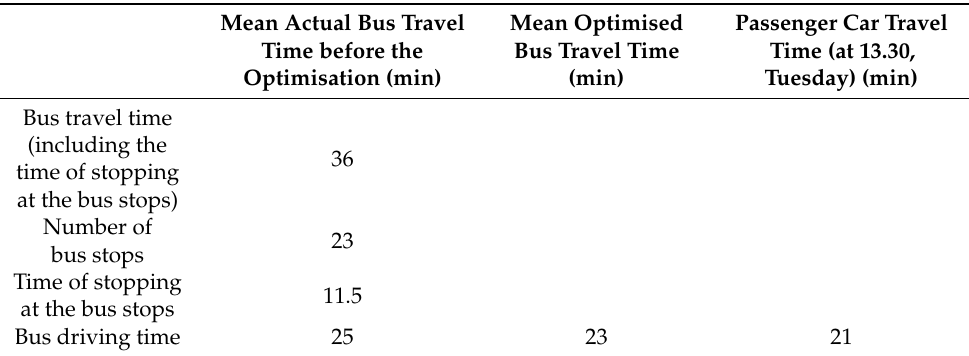
Table 7. Comparison of mean bus travel times before and after applying the